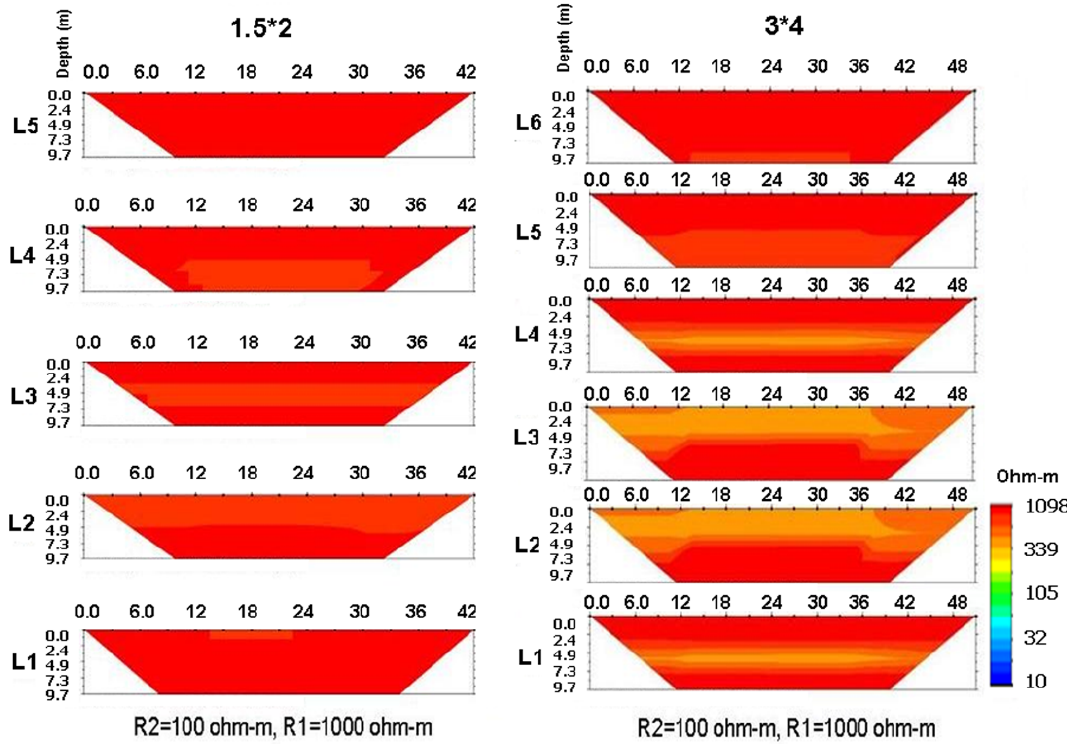
Figure 6. The influence of the pipeline size of the pipeline stratum model on the 3D effect.